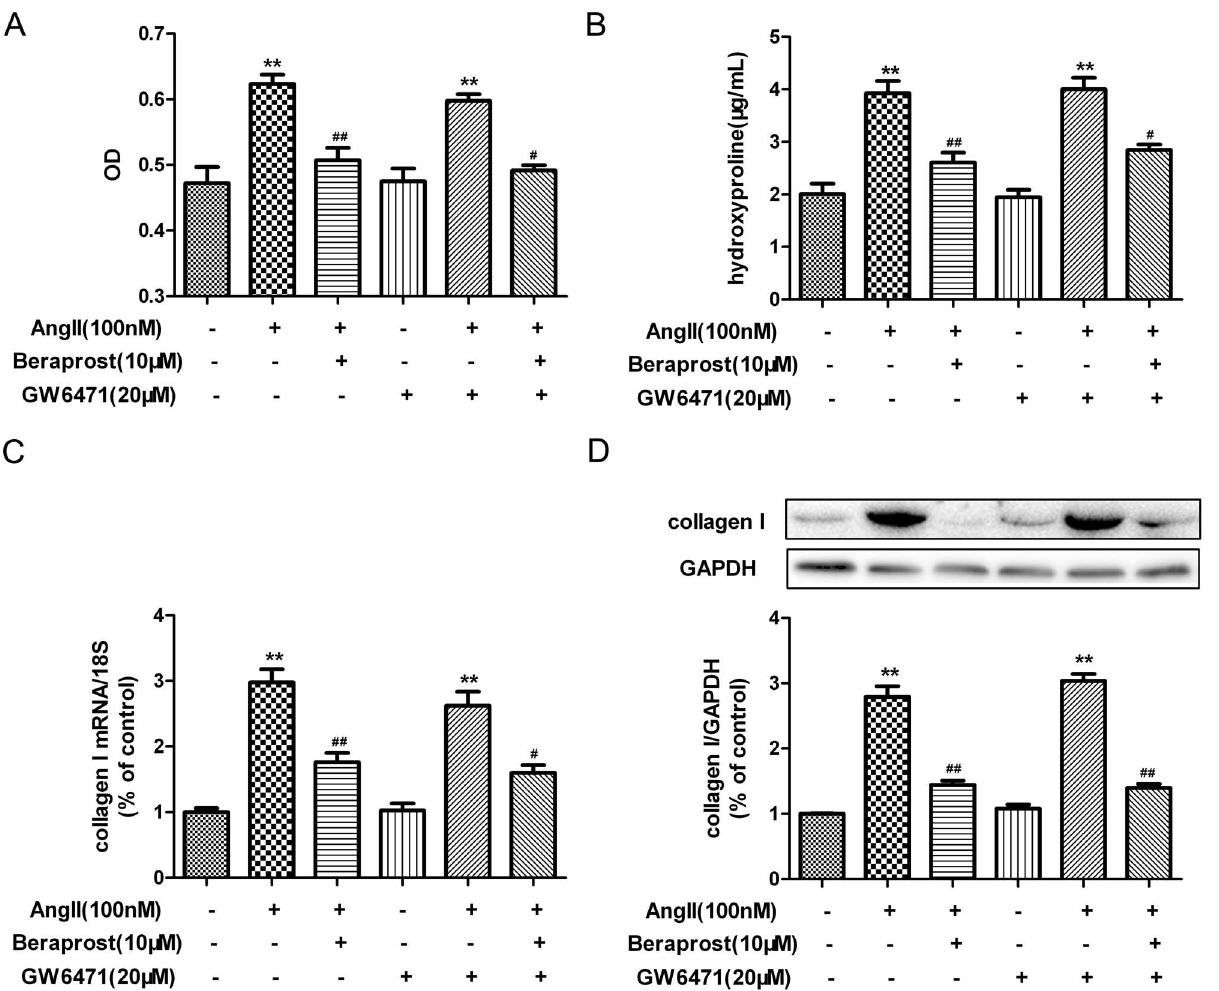
Figure 6. Peroxisome proliferators-activated receptor a (PPAR a ) is not involved in attenuating effect of beraprost on Ang II- induced cardiac fibroblast proliferation and collagen I synthesis. Neonatal rat cardiac fibroblasts were serum deprived for 24 h and pre- treated with specific PPAR a antagonist GW6471 (20 m M) for 4 h. Cells were then incubated with beraprost (10 m M) for 4 h followed by Ang II (100 nM) stimulation for an additional 24 h. (A) The number of cells was represented as an OD value using a cell count assay. (B) Content of hydroxyproline in cell culture medium was determined. (C) Collagen I mRNA expression was assessed by real time PCR. (D) Cell lysates were tested for collagen I protein expression by western blot. Values are expressed as mean 6 SEM. Cells without Ang II and beraprost stimulation served as a control (con). ** P , 0.01, compared with con, # P , 0.05, ## P , 0.01 compared with Ang II stimulated group following with or without GW6471 pre-treatment.